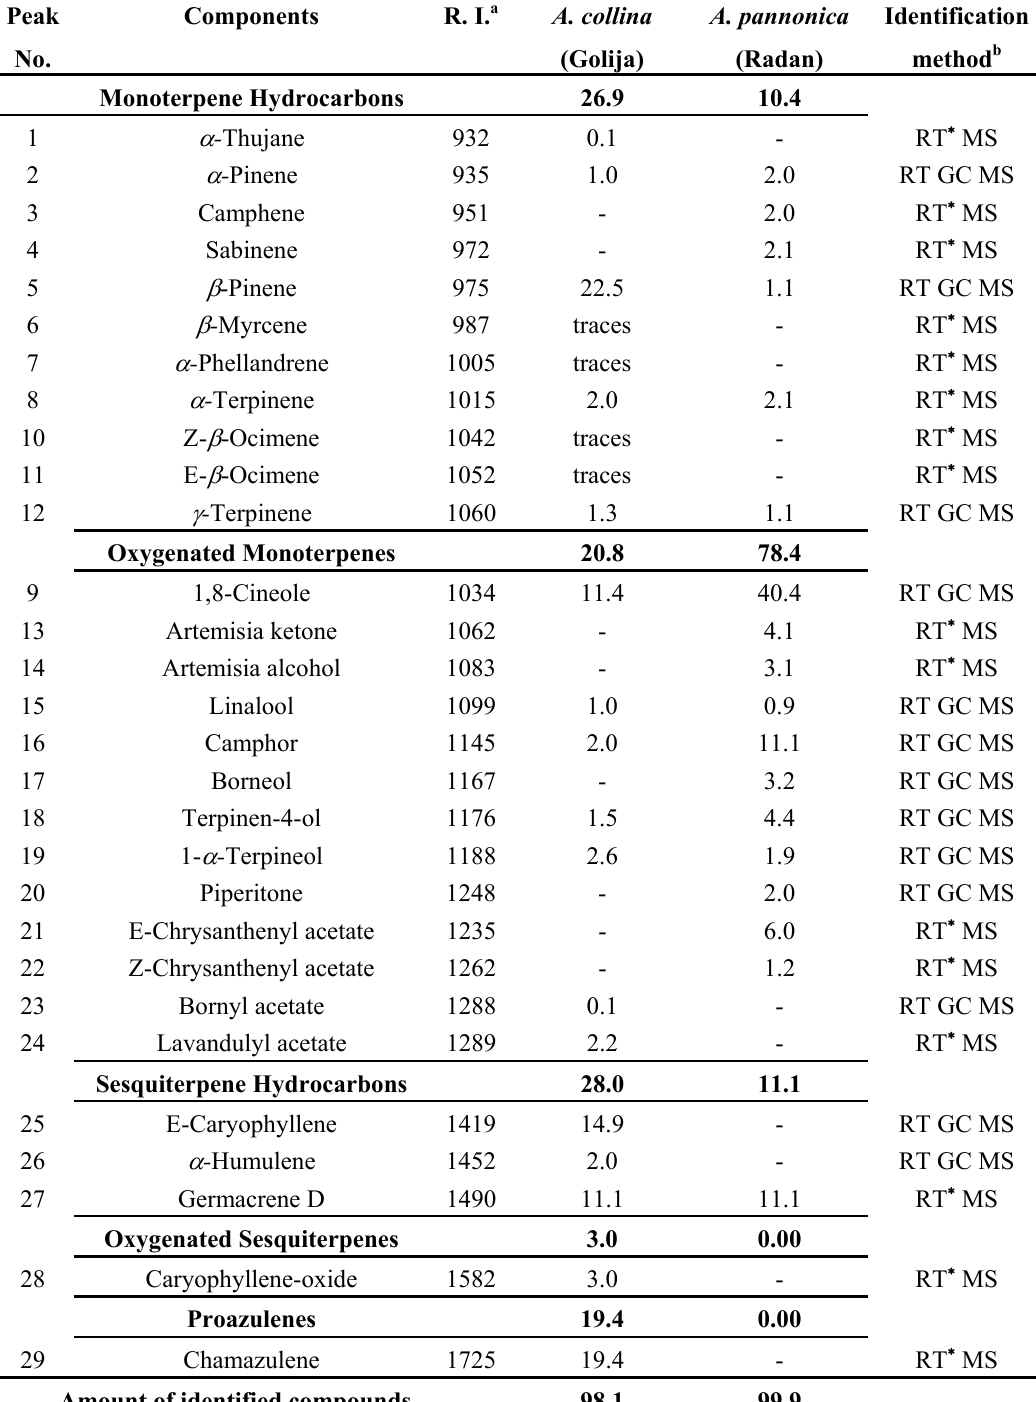
Table 1. Chemical composition (%) of A. collina s.l. and A. pannonica essential